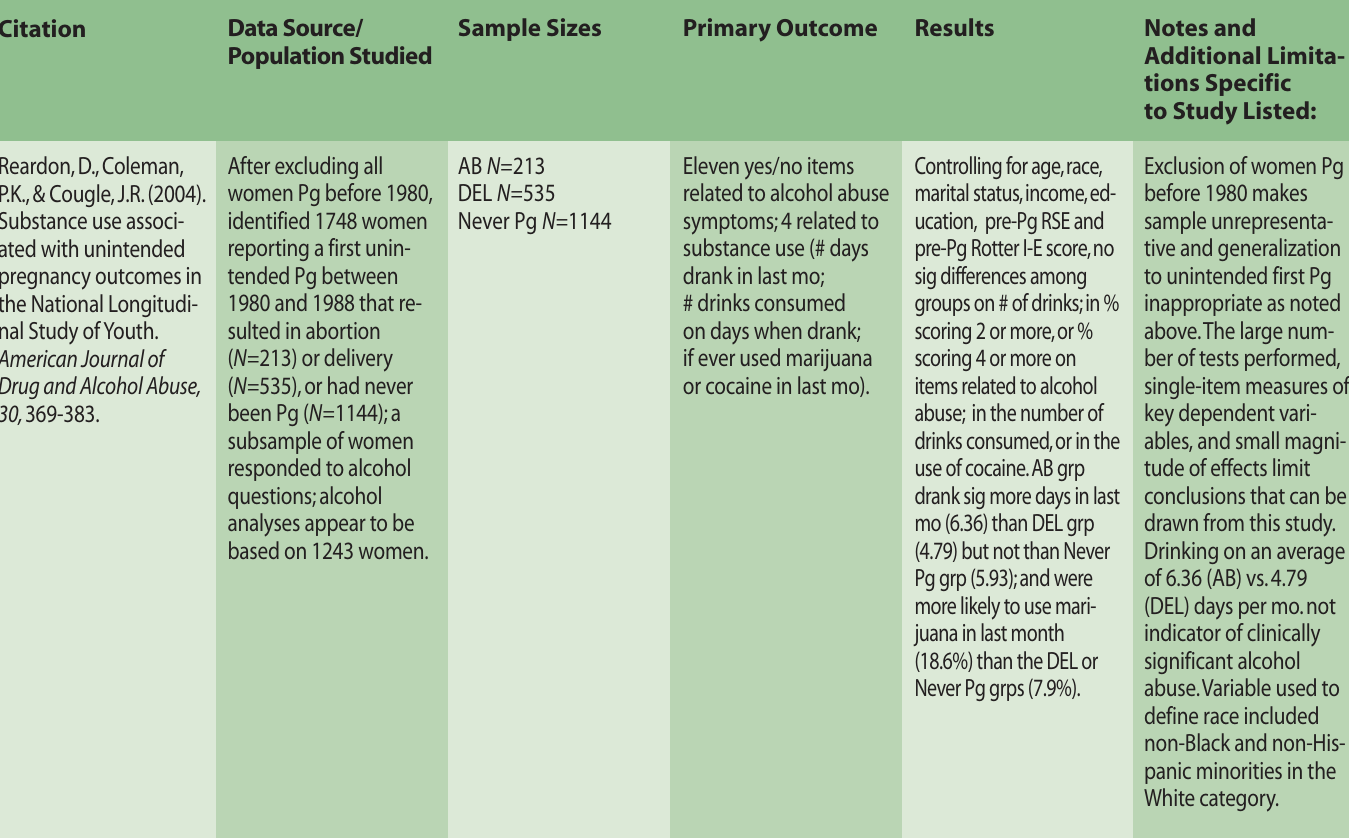
Table 2: Secondary Analyses of Survey Data–Abortion vs.Comparison